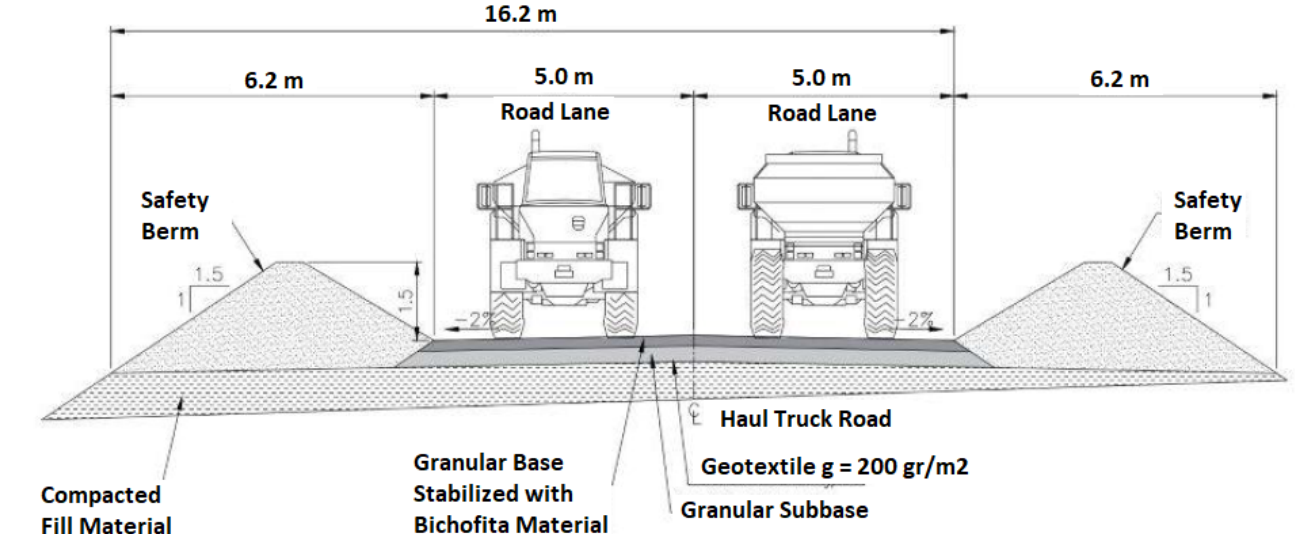
Figure 35. Huasco Haul Truck Road at Filtered Tailings Storage Facility—Typical Cross Section [54,55].